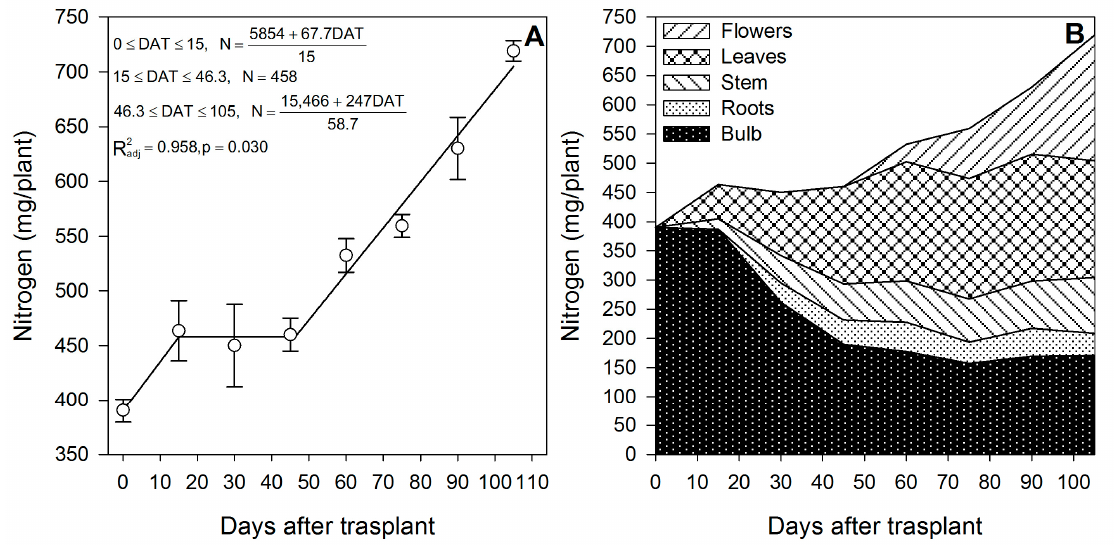
Figure 1. Nitrogen accumulation by lilium: ( A ) Segmented analysis of nitrogen accumulation over the growing season; ( B ) Nitrogen distribution in the lilium plant parts. Day 0 = transplant day, days 0 to 15 = sprouting and initial vegetative growth, days 15 to 60 = rapid vegetative growth plus flower buds formation, days 60 to 105 = blooming. DAT = days after transplant.